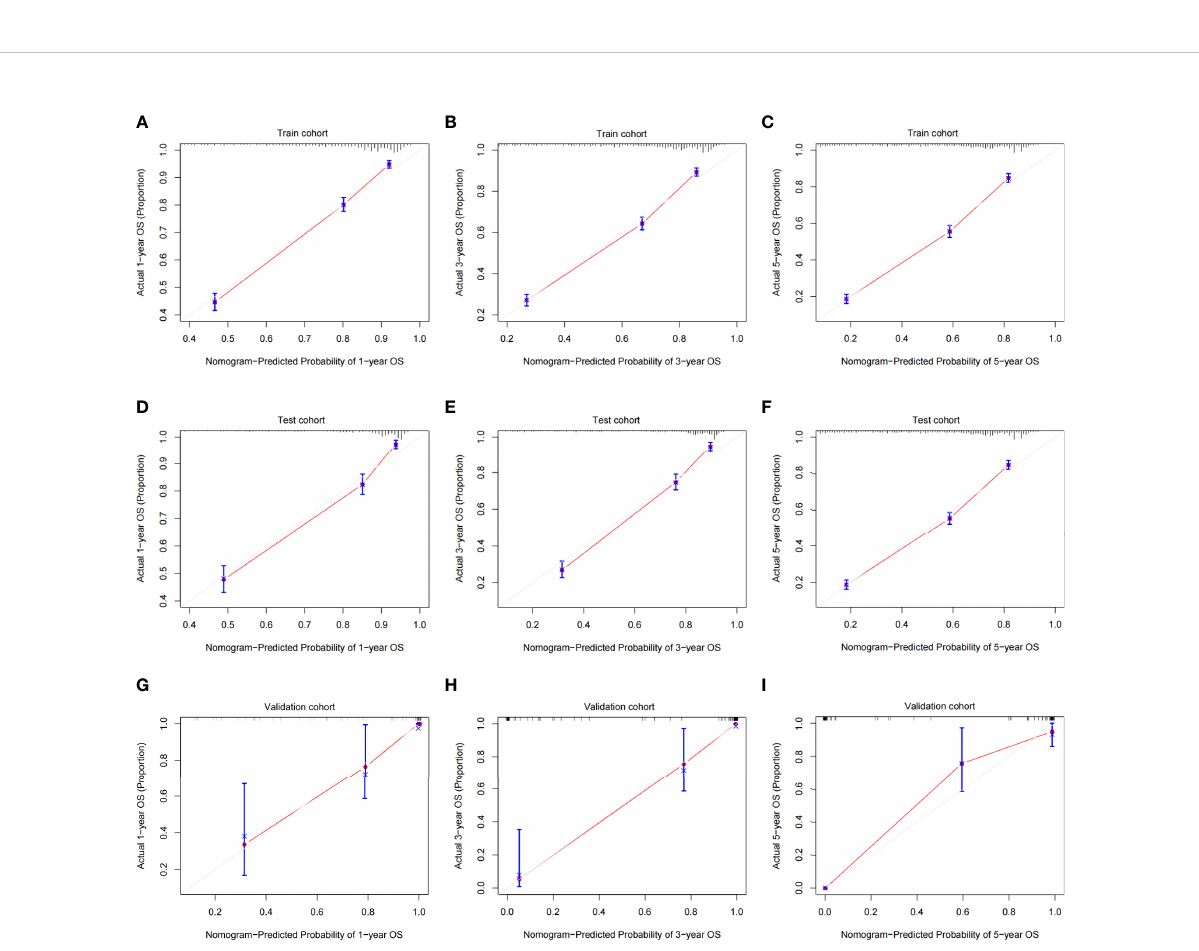
FIGURE 4 Calibration plots of the OS nomogram model. (A) 1-year calibration plot of OS using the train cohort. (B) 3-year calibration plot of OS using the train cohort. (C) 5-year calibration plot of OS using the train cohort. (D) 1-year calibration plot of OS using the test cohort. (E) 3-year calibration plot of OS using the test cohort. (F) 5-year calibration plot of OS using the test cohort. (G) 1-year calibration plot of OS using the validation cohort. (H) 3-year calibration plot of OS using the validation cohort. (I) 5-year calibration plot of OS using the validation cohort. OS, overall survival.